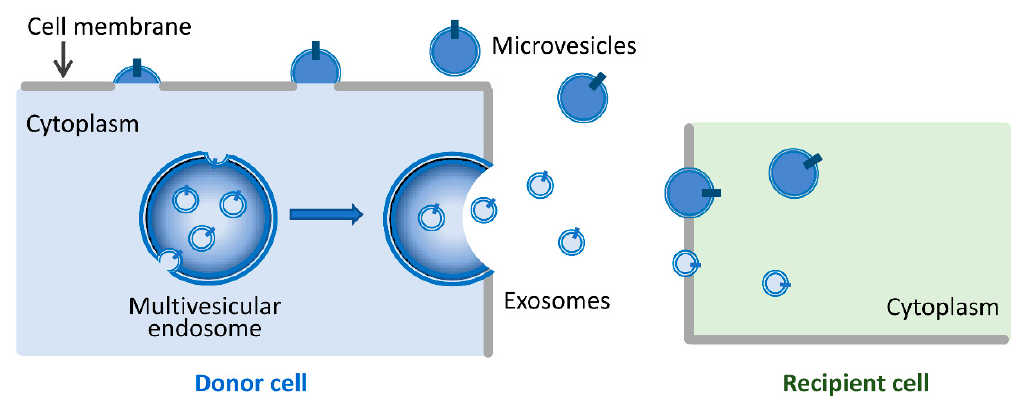
Figure 1. A schematic diagram depicting exosome and microvesicle generation and EV-mediated cell–cell communications. Exosomes are secreted upon fusion of multivesicular endosomes with the cell surface. Microvesicles are generated by the outward budding and fission of the cell membrane. Both exosomes and microvesicles can transfer their cargos from donor cells to recipient cells and consequently modulate recipient cell function.